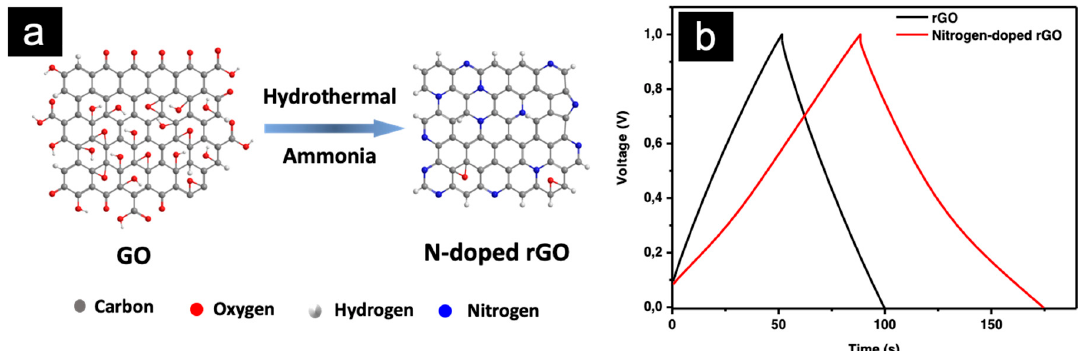
Figure 5. ( a ) Preparation of nitrogen-doped rGO from graphene oxide (GO) and ammonia solution (as the nitrogen precursor) through a hydrothermal process; ( b ) a galvanostatic charge–discharge (GCD) plot of rGO and a nitrogen-doped rGO.